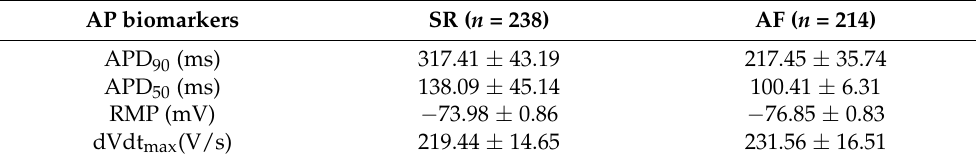
Table 2. Experimental data on AP biomarkers [58] under atrial fibrillation (AF) and sinus rhythm (SR)